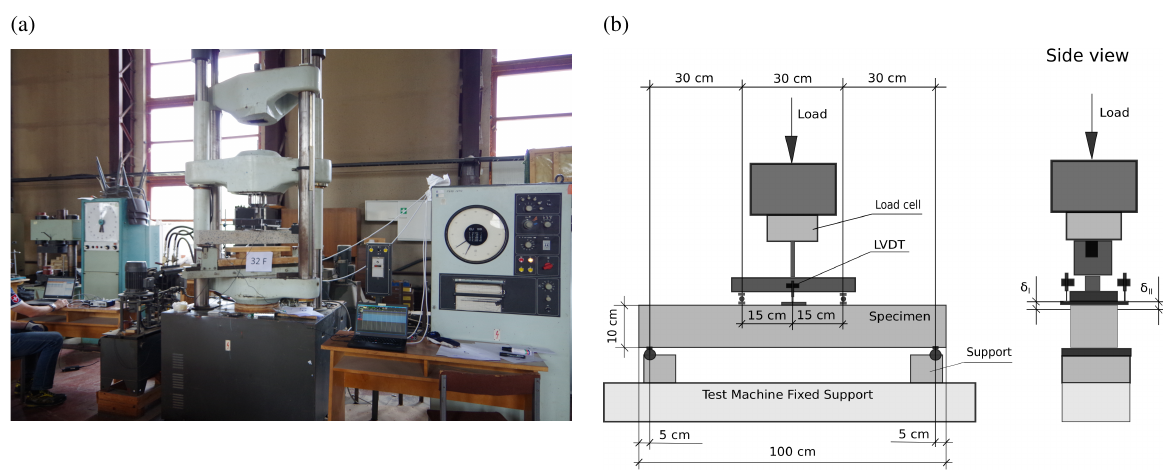
Fig. 3. Four point bending test: (a) photo of the setup, (b)